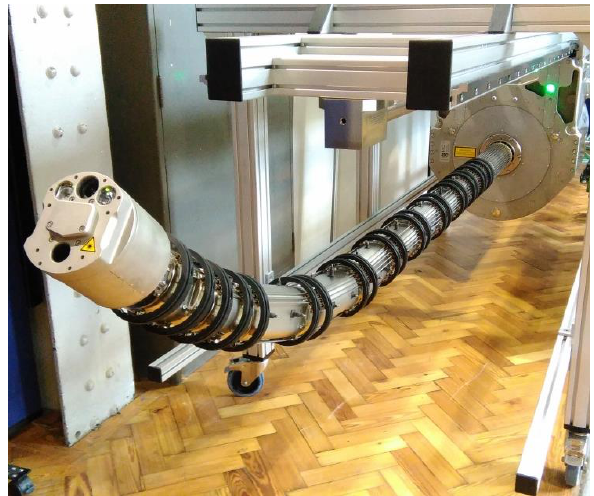
Figure 1. OC Robotics snake arm